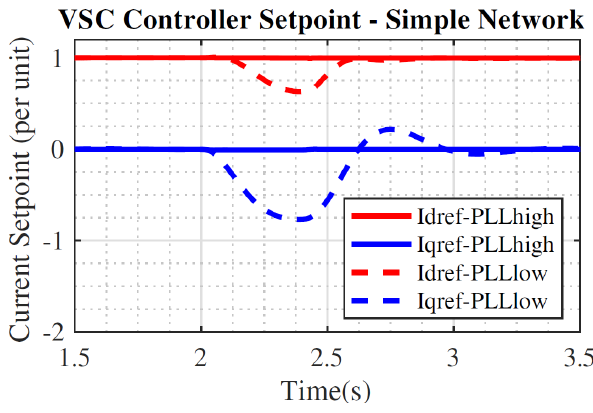
Figure 9. Current controller reference signal from dual outer loop controllers—PLL with low bandwidth (dash line), PLL with high bandwidth (solid line).